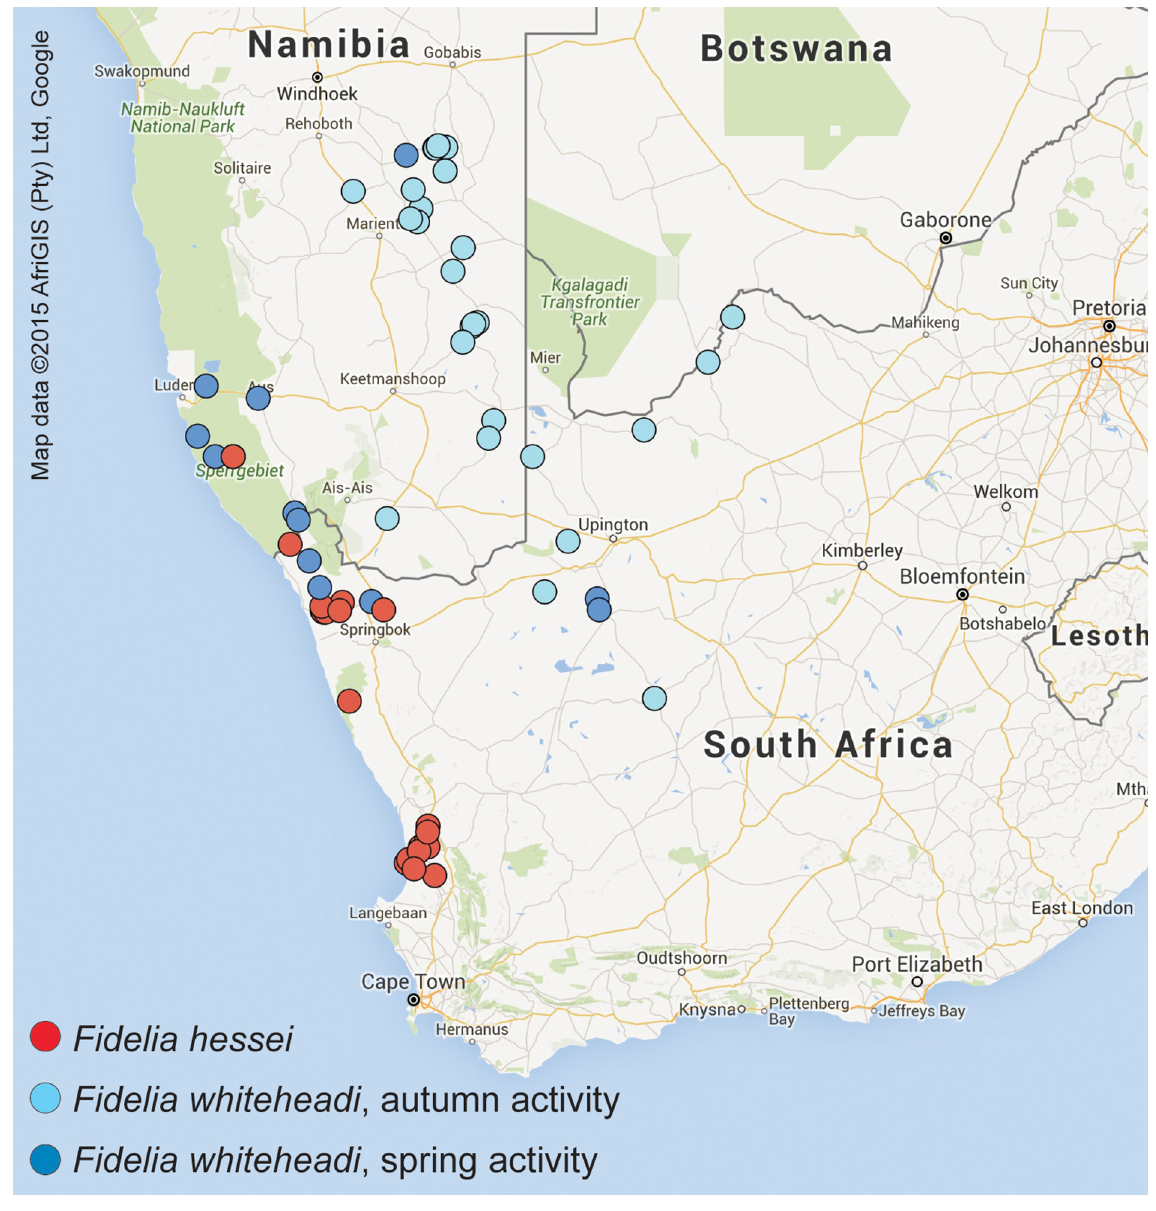
Fig. 4. Distribution map of Fidelia hessei Whitehead & Eardley, 2003 (red dots), Fidelia whiteheadi Litman & Kuhlmann sp. nov., autumn period of activity (light blue dots) and Fidelia whiteheadi Litman & Kuhlmann sp. nov., spring period of activity (dark blue dots). The northernmost occurrence of F. hessei shown on the map corresponds to morphologically ambiguous specimens collected in the region around the Klinghardt Mountains of Namibia; the identification of the specimens from this region should be corroborated with DNA